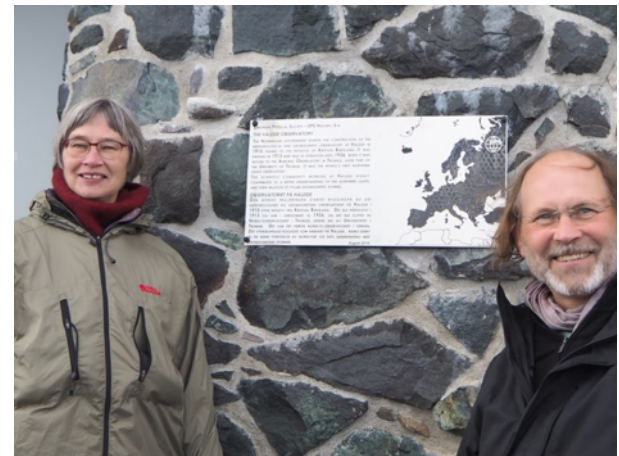
Figure 10. Professor Åshild Fredriksen from the University of Tromsø, UiT The Arctic University of Norway and the Secretary General of EPS David Lee in front of the plaque unveiled at the stonewall of the old observatory on Haldde (photo: Asgeir Brekke,